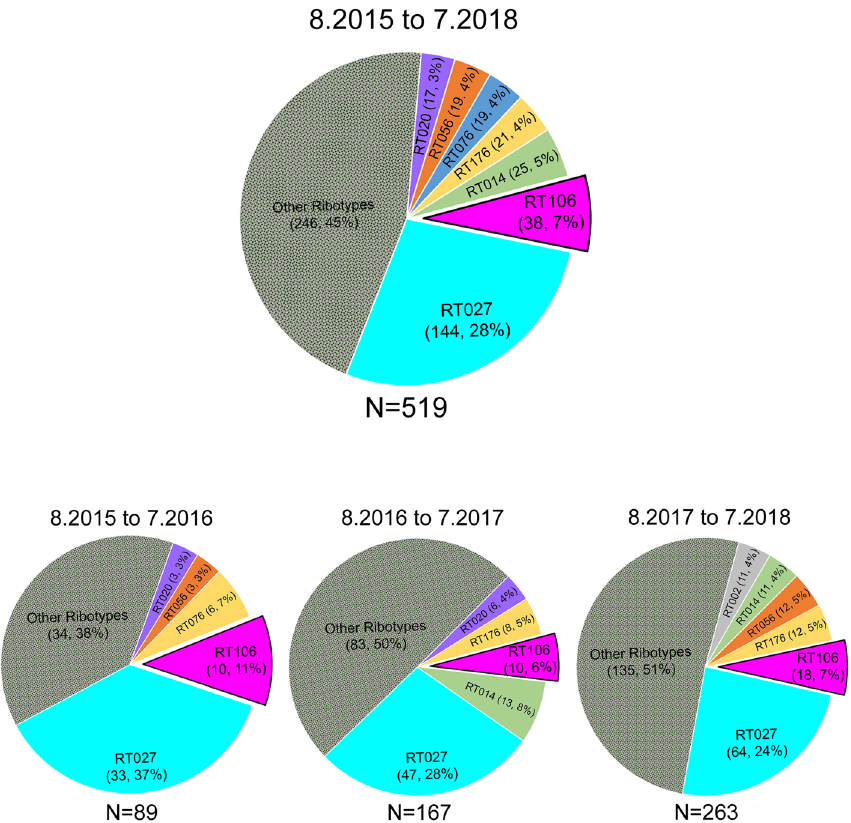
Figure 1. RT106 is the second most prevalent molecular type in a Tucson-area hospital. Top chart depicts ribotype distribution of 519 tcdB PCR-positive and/or TcdA/B ELISA-positive C. difficile strains from patient stool samples collected from August 2015 to July 2018 (8.2015 to 7.2018). Ribotype frequency and percent of total sample size are shown in parenthesis. Overall, RT106 is the second most frequently isolated molecular type, while RT027 is the most prevalent ribotype. Bottom charts depict ribotype distribution in 12-month periods. RT106 ranked second to RT027 as the most frequently isolated molecular type during 8.2015 to 7.2016 and 8.2017 to 7.2018. RT106 was the third most dominant ribotype during 8.2016 to